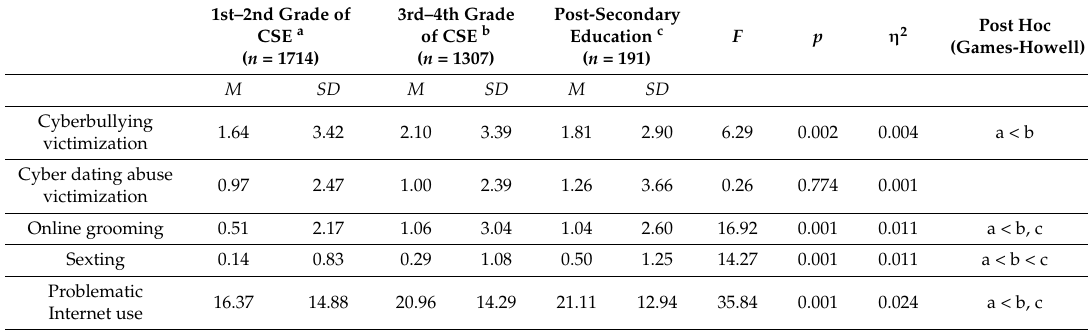
Table 2. Differences as a function of educational stage (1st–2nd, 3rd–4th grades of CSE and Post-secondary Education) in the risks ( n = 3212, except for the case of cyber dating abuse with n = 1061).